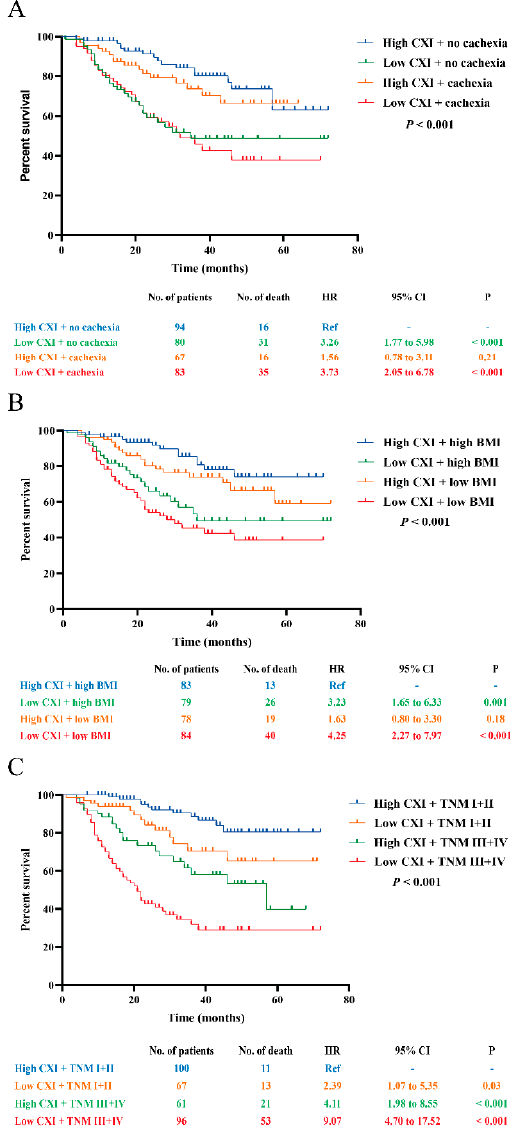
Figure 4. Survival analysis for the combination of CXI and ( A ) cachexia; ( B ) BMI; ( C ) TNM stage.